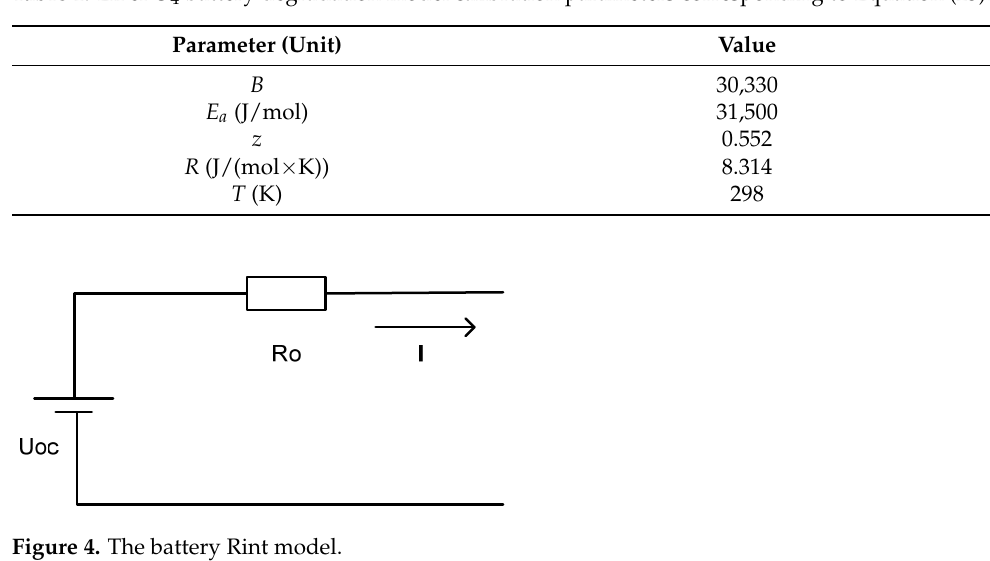
Table 1. LiFePO4 battery degradation model calibration parameters corresponding to Equation (23).